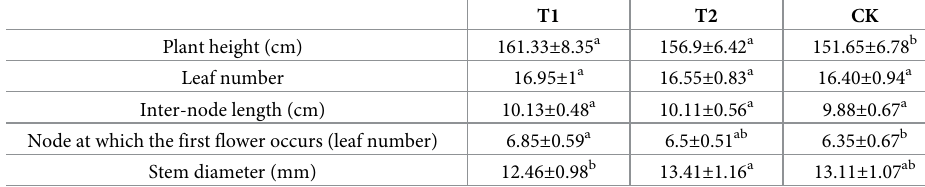
Table 3. Effects of SL on tomato plant morphology tomato.